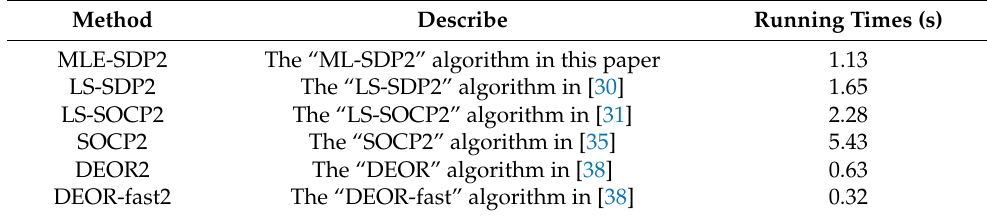
Table 5. Average running times of L 0 unknown